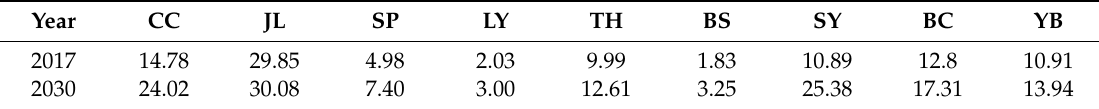
Table 9. The change in surface water